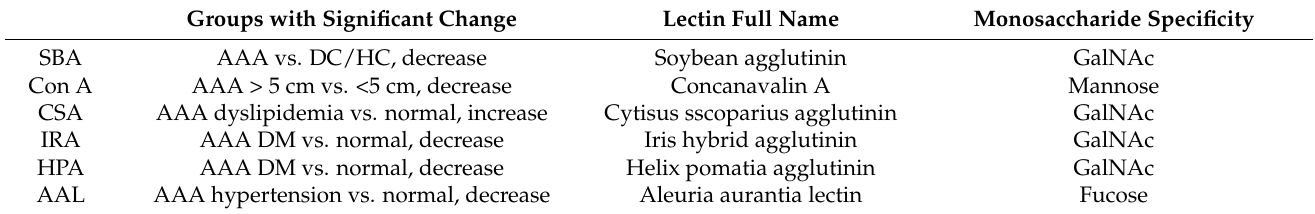
Figure 2. Significant lectin microarray results for AAA patients. The following rules were used to identify significant differences for intra-disease group analysis: ( A ) fold change [group1(S/N)/group2(S/N)] ≥ 1.33 or <0.75, ( B ) p -value < 0.05. ( A ) Microarray result for SBA in inter-group analysis. ( B ) Microarray result for ConA between patients with AAA of different diameters. ( C ) Microarray result for CSA between AAA patients with or without dyslipidemia. ( D ) Microarray result for IRA between AAA patients with or without diabetes. ( E ) Microarray result for HPA between AAA patients with or without dyslipidemia. ( F ) Microarray result for AAL between AAA patients with or without hypertension. Table 3. Sugar specificity for lectins with significant differences in inter- and intra-group analysis.